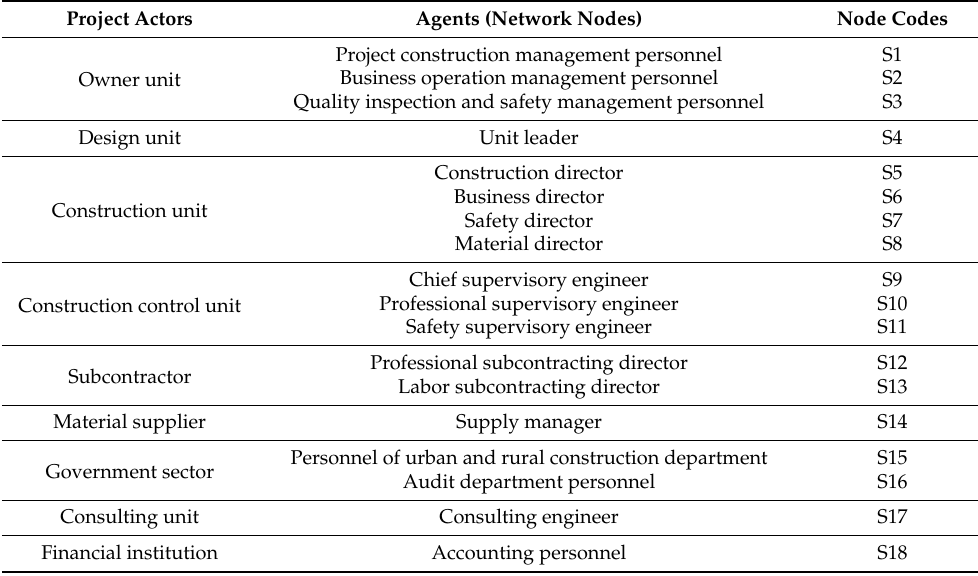
Table 1. List of relationship network